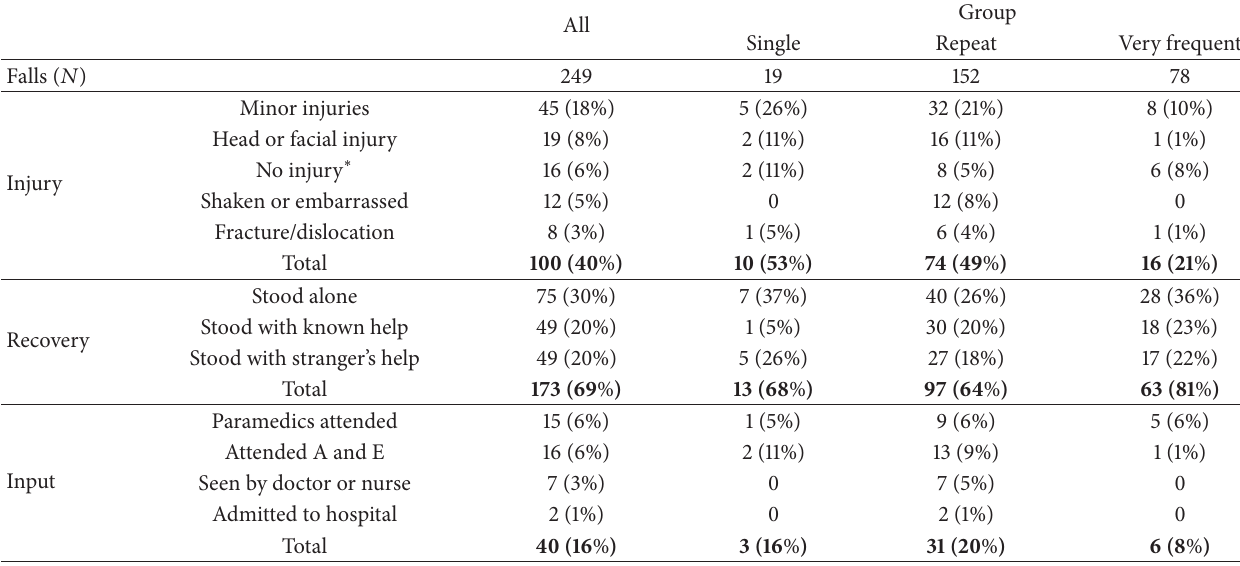
Table 4: Immediate consequences of falls beyond home ( 𝑁 = 249